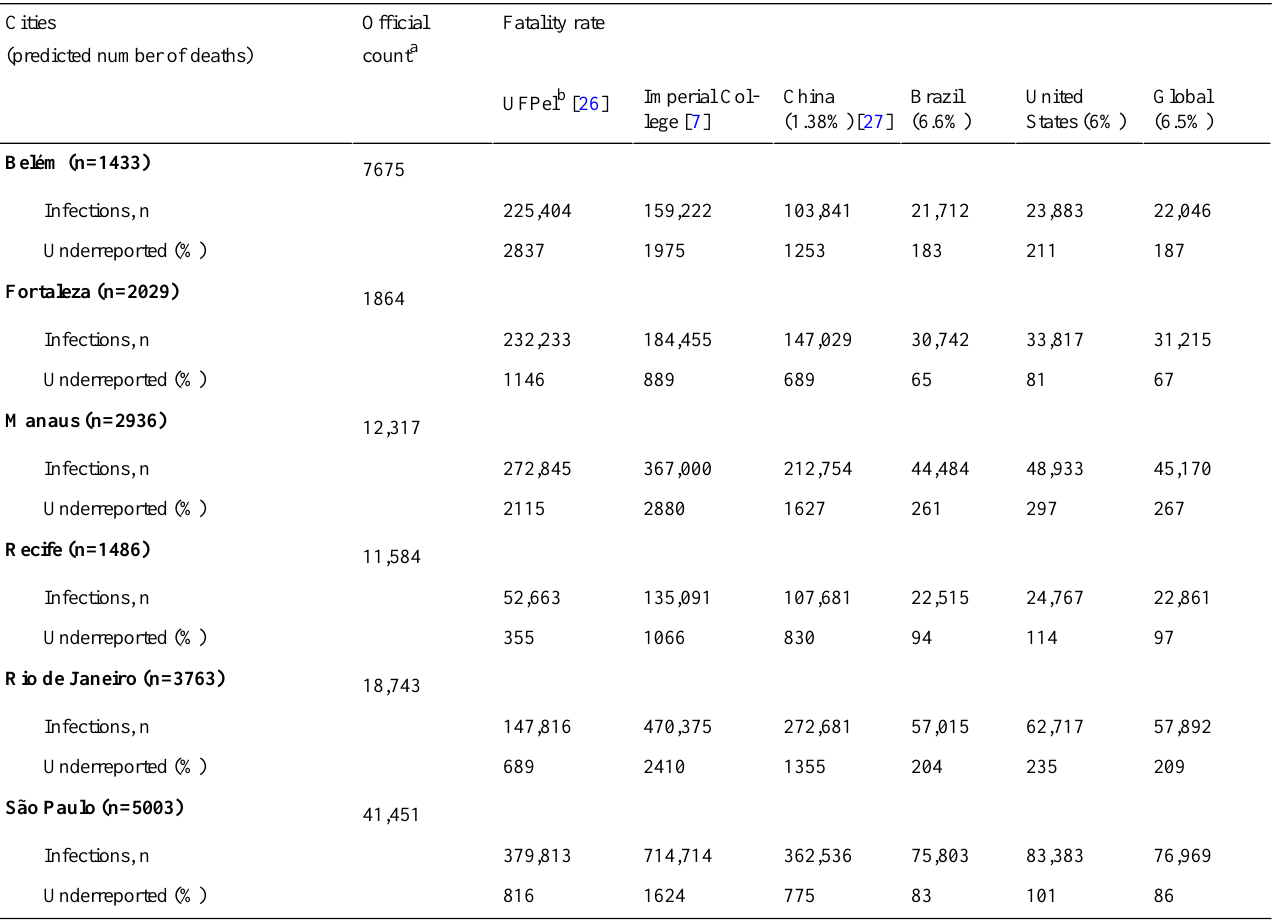
Table 7. Estimated number of infection cases and percentage of cases underreported considering differing estimations in fatality rate.